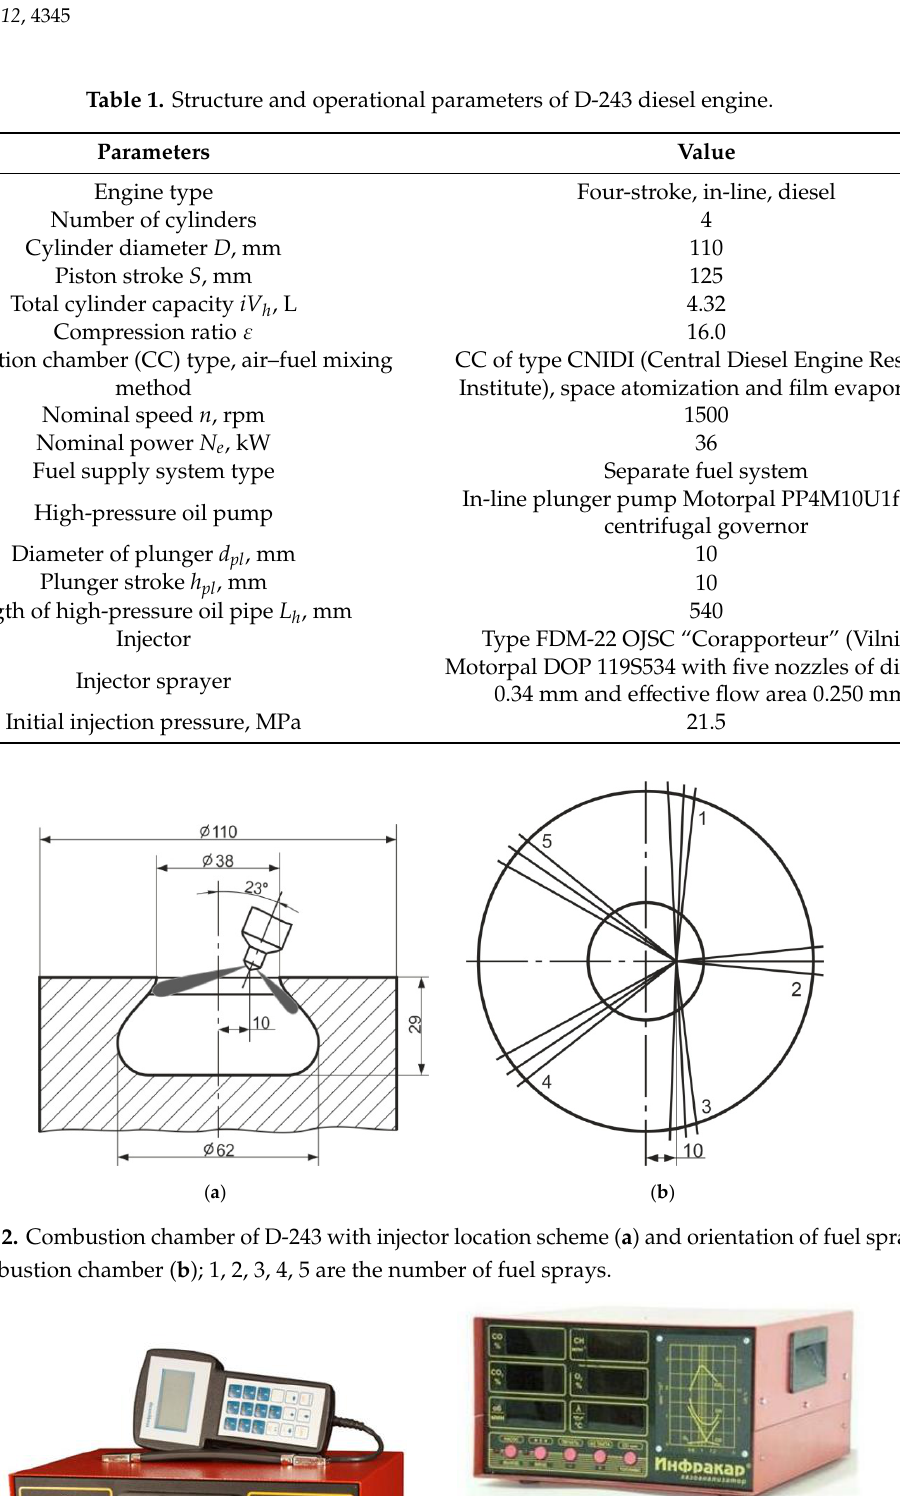
– Figure 4. Ultrasonic bath used for preparing mixtures of petroleum diesel fuel with carbon nanotubes (CNTs). The dispersion of CNTs into DF was carried out as follows. After the addition of CNTs to petroleum DF during their mixing in the ultrasonic bath, the state of the mixed fuel was continuously monitored. By about the 10th minute of mixing the components, the mixture became almost homogeneous. After this, mixing continued for about 5 min to ensure complete homogeneity of the mixture. Approximately the same duration of mixing motor fuel with CNTs (15 min) was realized in [10]. This method of mixing CNTs with motor fuels was also implemented in [13,14]. In view of the use of this dispersion method of motor fuels with CNTs in other published works, an